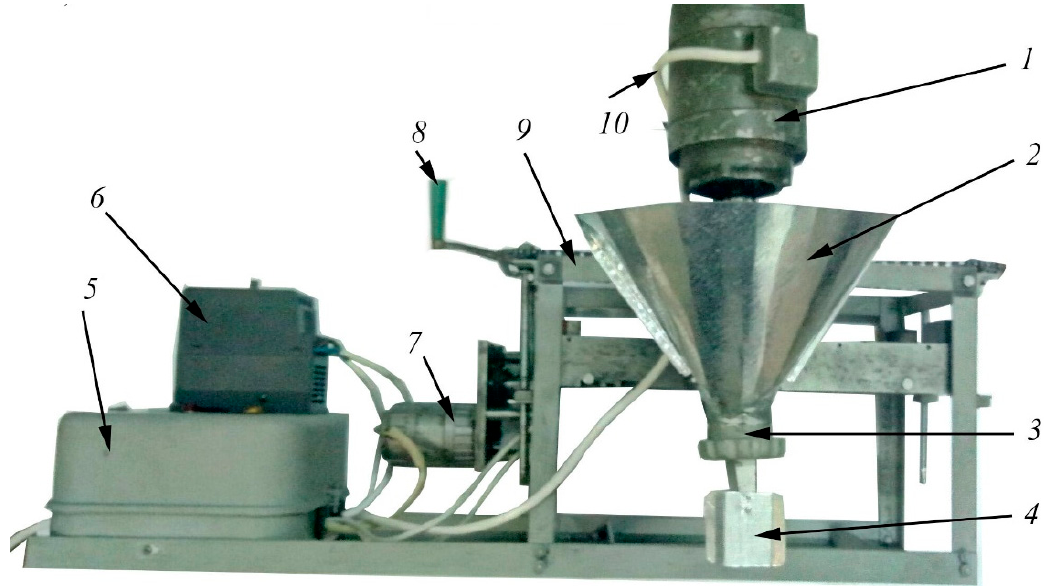
Figure 1. Laboratory 3D printer. 1—electric motor of the extruder; 2—hopper of building mixture; 3—auger; 4—mouthpiece; 5—control panel; 6—frequency converter of electricity; 7—reverse motor moving the extruder in the horizontal direction; 8—manual drive moving the extruder in the ver- tical direction; 9—frame; 10—power cable of electric motors.